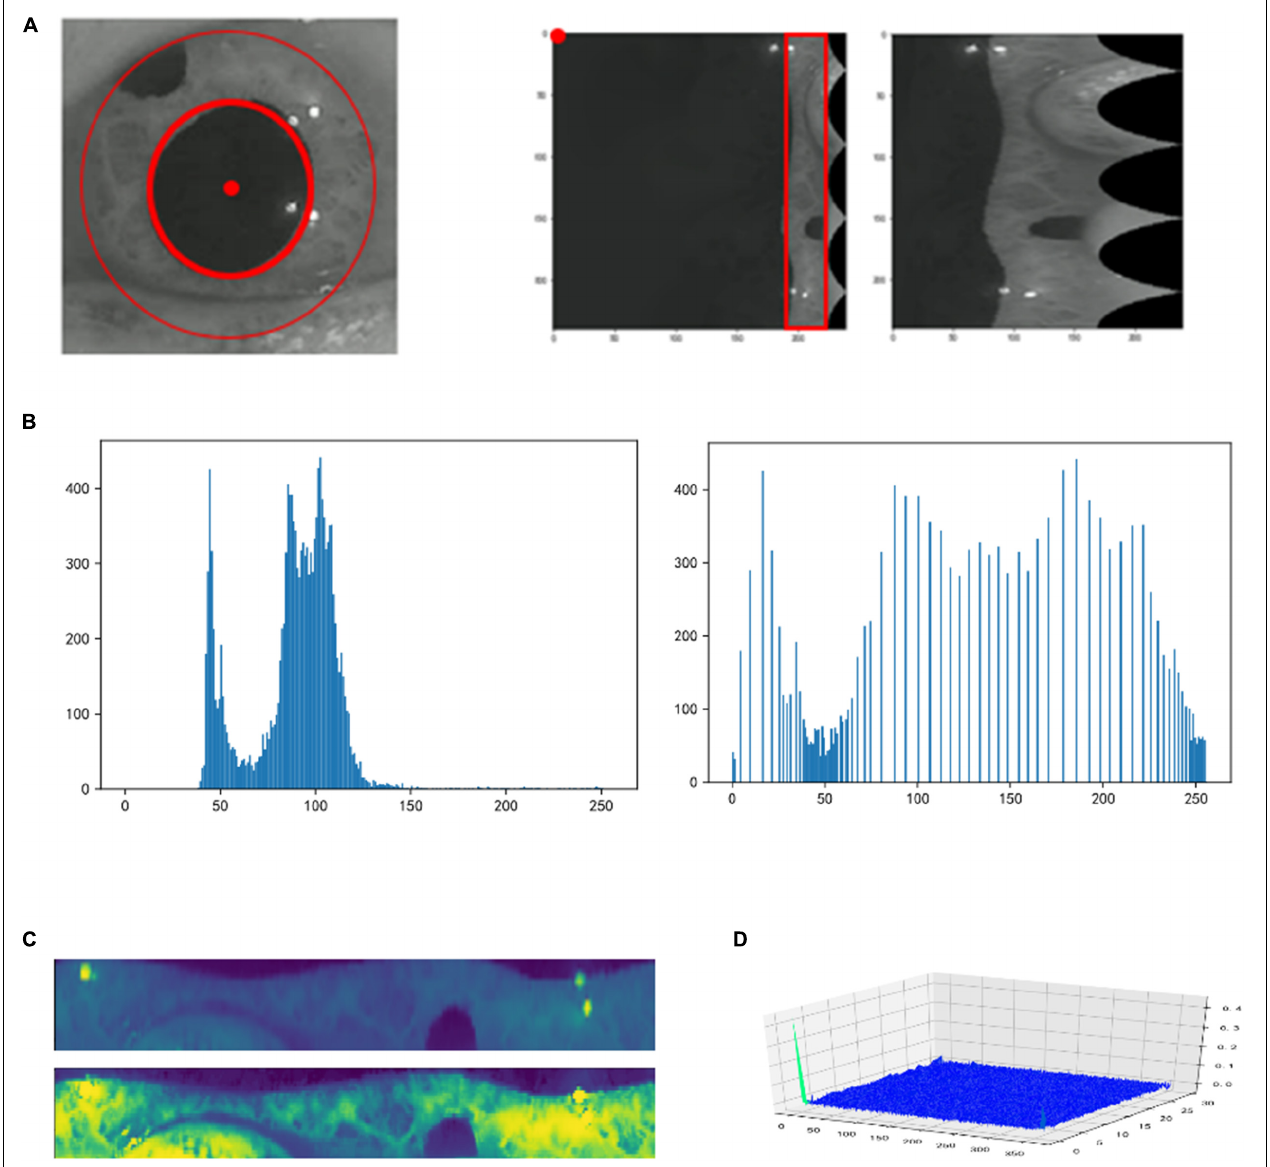
FIGURE 3 | Iris torsion measure. (A) Iris extraction. Circles: iris boundaries; rectangles: log-polar (left) and linear-polar transform (right). (B) Original and equalised histogram. (C) Iris patterns before and after equalisation. (D) Phase-only correlation function.